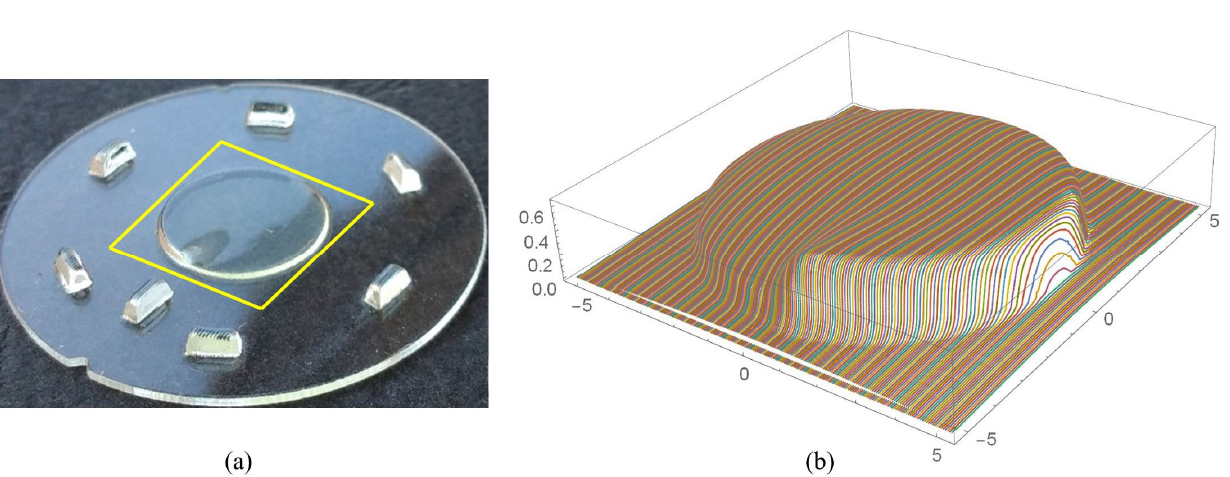
Figure 5. ( a ) Measuring window and ( b ) superelevated 3D-plot of the 210 measurement profiles.